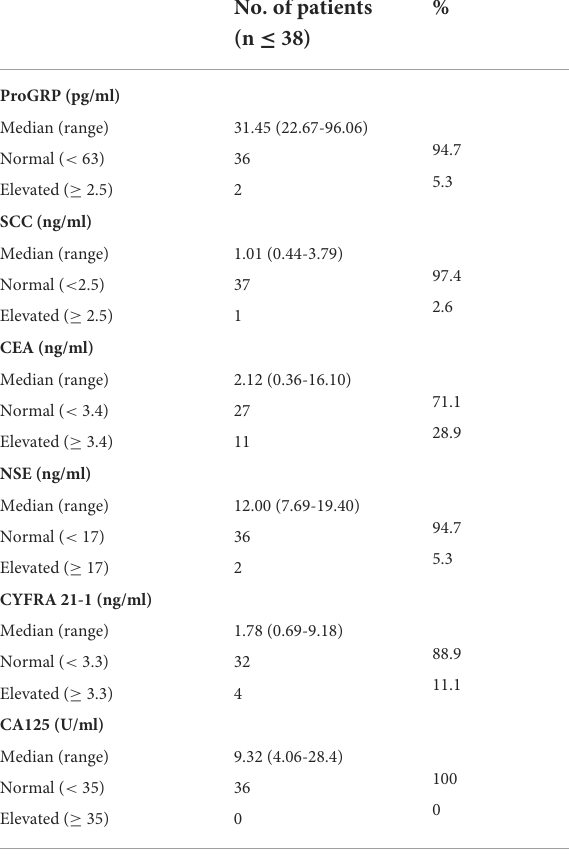
TABLE 2 Six cancer markers serum level in patients with lung cancer. No. of patients